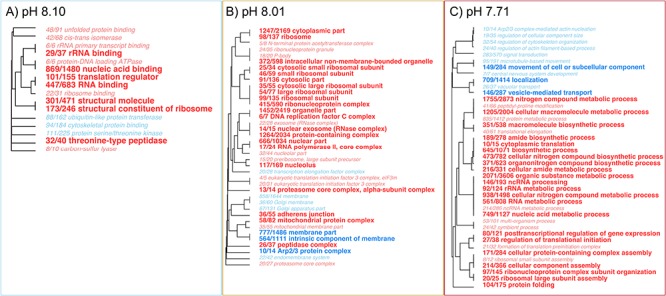
Gene ontology enrichment and term clustering of the ANODEV results comparing differential expression between the two temperature experiments (+4 °C vs. -1 °C) at each pH treatment (8.10, 8.01, 7.71). Significantly enriched gene ontologies were plotted with upregulated ontologies plotted in red text and downregulated ontologies in blue text. The boldness of the text represents FDR cut offs for significance of 0.1,0.05, and 0.01. Finally, the clustering identifies closely related ontologies.=